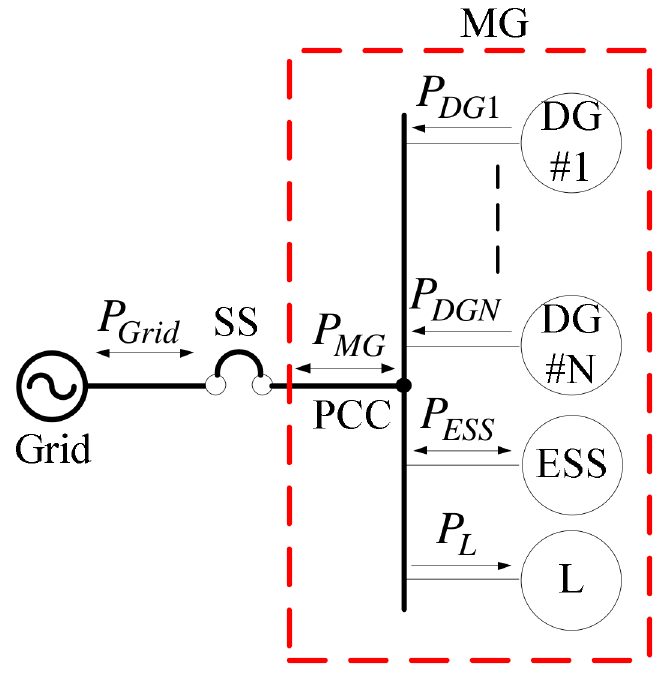
Figure 1. Architecture of a typical grid-connected